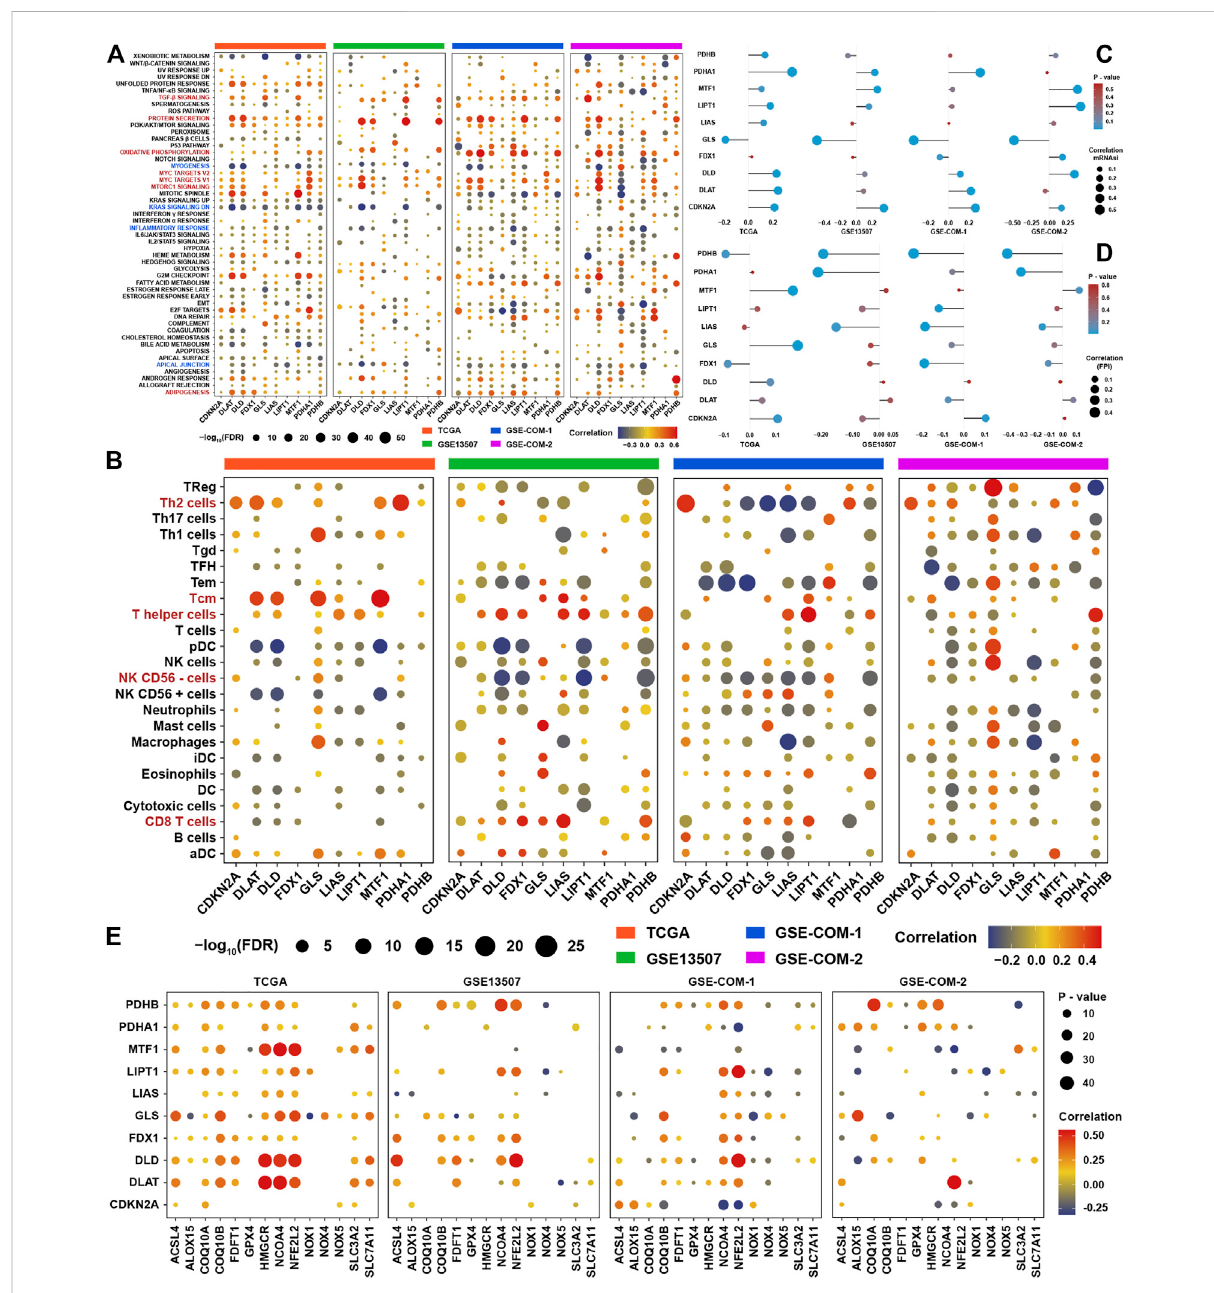
FIGURE 3 Functional characteristicsofcuproptosisregulators inBLCA (A) .Correlation analysisamongGSVAscoresandtheexpressionoftencuproptosis regulators in the four BLCA cohorts (B) . Correlation analysis among in fi ltration levels of immune cells and the expression of ten cuproptosis regulators in four BLCA cohorts. Vacant positions represent no statistical signi fi cance between the term and cuproptosis regulator. The size of dots showedthecorrelationstrengthbetweenregulatorsandfunctionterms.Thedepthofthecolorindicatesthestrengthofthecorrelation (C) .The correlation analysis between ten cuproptosis regulators and mRNAsi in the four BLCA cohorts (D) . The correlation analysis between ten cuproptosis regulators and the ferroptosis index in the four BLCA cohorts (E) . The correlation analysis among ten cuproptosis regulators and ferroptosis regulators in the four BLCA